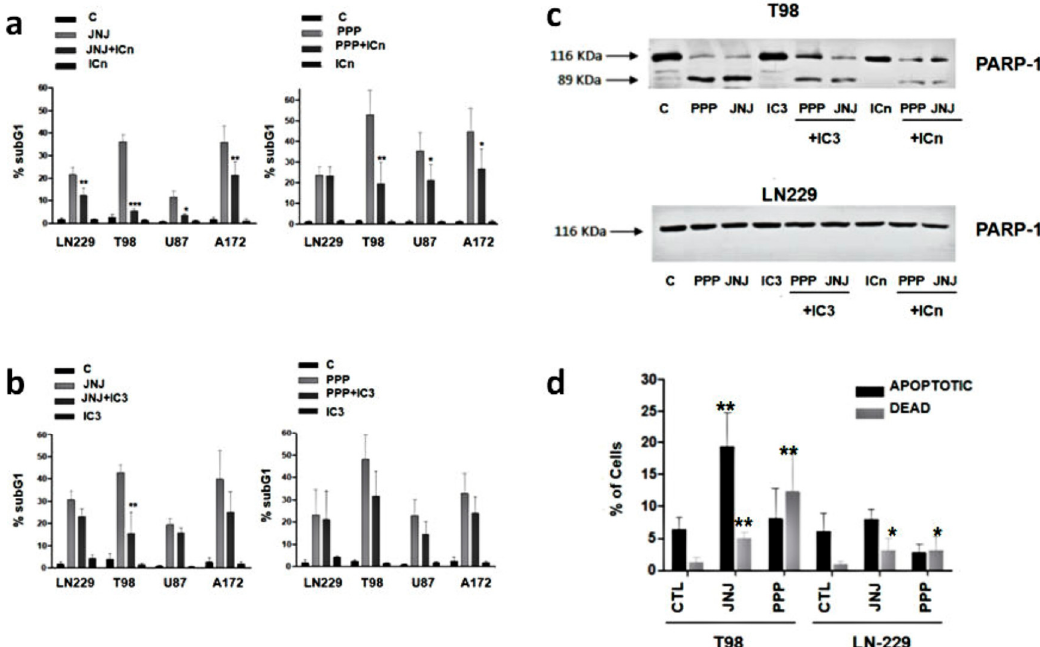
Figure 5. Role of caspases in JNJ and PPP-induced cell death. ( a ) Effects of the pan caspase inhibitor. GBM cell lines were left untreated ( c ) or treated with 500 nM JNJ (left panel), 500 nM PPP (right panel), 25 µ M of the general caspase inhibitor Z-VAD (OMe)-FMK (ICn), or a combination of either JNJ and ICn and PPP and ICn for 72 h, after a 30 min pretreatment period with only ICn. Then, cells were subjected to cell cycle analyses, as described in Materials and Methods. The percentage of cells in the SubG 1 phase is represented as the average of 6 ( n = 6) independent experiments. Difference between means was statistically significant * ( p < 0.05), ** ( p < 0.01), *** ( p < 0.001). ( b ) Effects of the specific caspase-3 inhibitor. GBM cell lines were left untreated (C) or treated with 500 nM JNJ (left panel), 500 nM PPP (right) panel), 5 nM of the specific caspase-3 inhibitor Z-D(OMe)E(Ome)VD(OMe)-FMK (IC3), or a combination of either JNJ and IC3 and PPP and IC3 for 72 h, after a 30 min pretreatment period with only IC3. Then, cells were subjected to cell cycle analyses, as described in Materials and Methods. The percentage of cells in the SubG 1 phase is represented as the average of three independent experiments. Difference between means was statistically significant * ( p < 0.05), ** ( p < 0.01). ( c ) PARP processing. T98 and LN-229 cells were left untreated ( c ) or treated with 500 nM JNJ or 500 nM PPP, in the presence or absence or 25 μ M Z-VAD (OMe)-FMK (ICn), or 5 μ M Z-D(OMe)E(Ome)VD(OMe)-FMK (IC3). Cells were subjected to Western